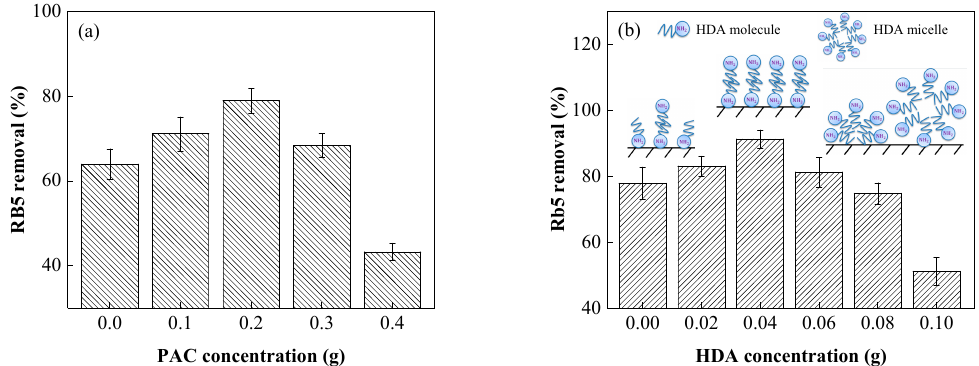
Figure 1. E ff ect of ( a ) powdered activated carbon (PAC) and ( b ) hexadecylamine (HDA) concentrations Figure 1. Effect of ( a ) powdered activated carbon (PAC) and ( b ) hexadecylamine (HDA) on the adsorption e ffi ciency of reactive black 5 (RB5) onto the adsorbents (20 mg of beads, 200 mL of concentrations on the adsorption efficiency of reactive black 5 (RB5) onto the adsorbents (20 mg of 20 mg / L of RB5, pH = 6, 25 ◦ C, 24 beads, 200 mL of 20 mg/L of RB5, pH = 6, 25 °C, 24 h).